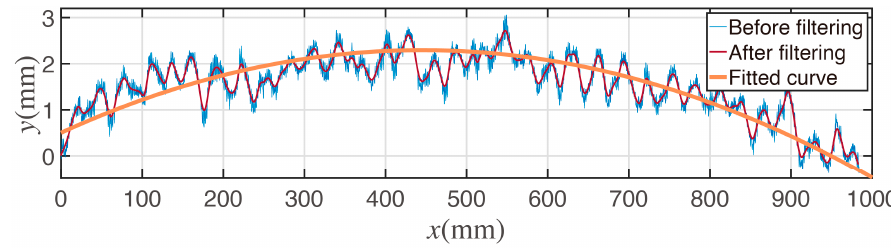
Figure 11. Arc fitting for forward-moving trajectory.